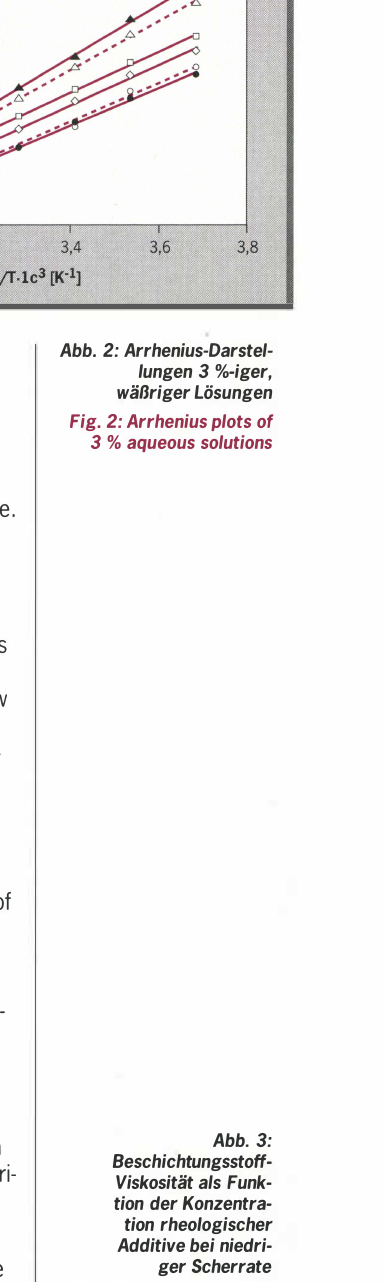
Fig. 3: Coating viscosity as a function of RA concentration -low shear